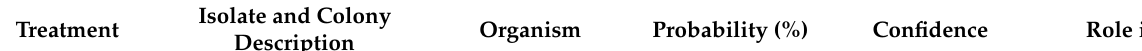
Table 4. Microbial consortium of spinach shoots treated with paracetamol for eight